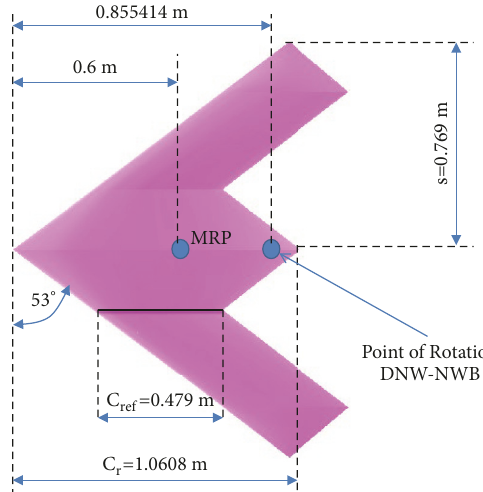
Figure 1: Geometric parameters of the SACCON UCAV configura- tion.